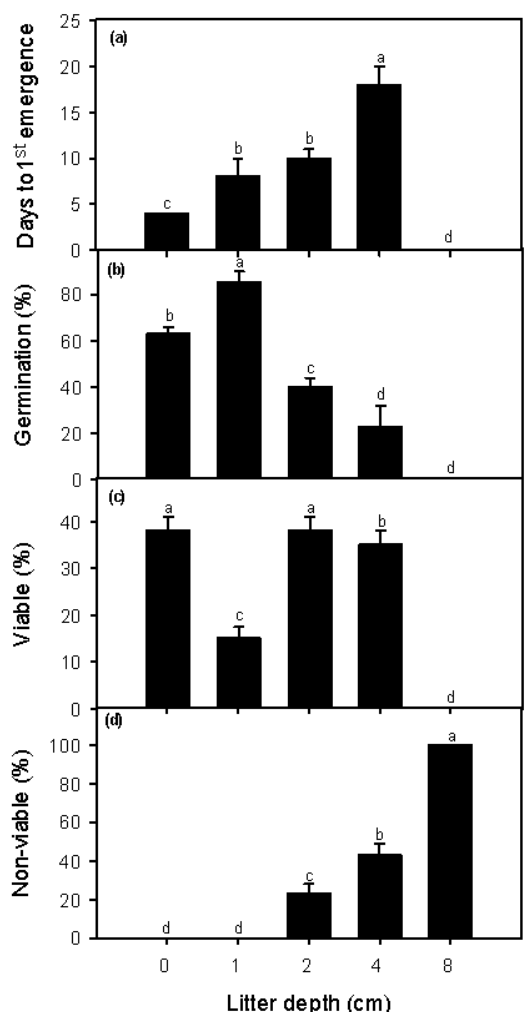
Figure 1. Days to first germination ( a ), germination percentage ( b ), and percentages of viable ( c ) and non-viable ( d ) seeds of Prosopis julflora for the five leaf litter depth treatments under greenhouse conditions. The value of germination percentage, present viable seeds, and percentage of non-viable seeds sums to 100% for each litter depth. Different letters indicate significant differences between treatments (ANOVA, p < 0.05).